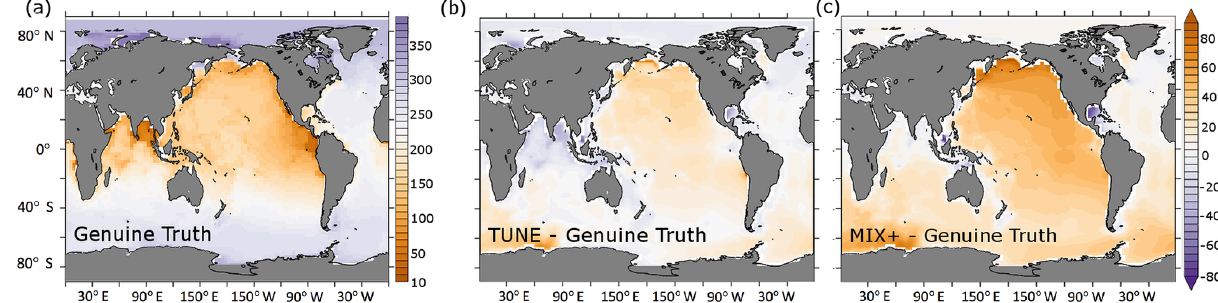
Figure 7. (a) Simulated depth-averaged oxygen concentrations in millimoles of oxygen per cubic meter (mmolO 2 m − 3 ) for the historical simulation of the Genuine Truth. Panel (b) refers to the differences between TUNE and the Genuine Truth of simulated depth-averaged oxygen concentrations in units mmolO 2 m − 3 for the historical simulations (see Sect. 2.2.2). Panel (c) is identical to (b) but shows the difference to MIX+ instead of TUNE.